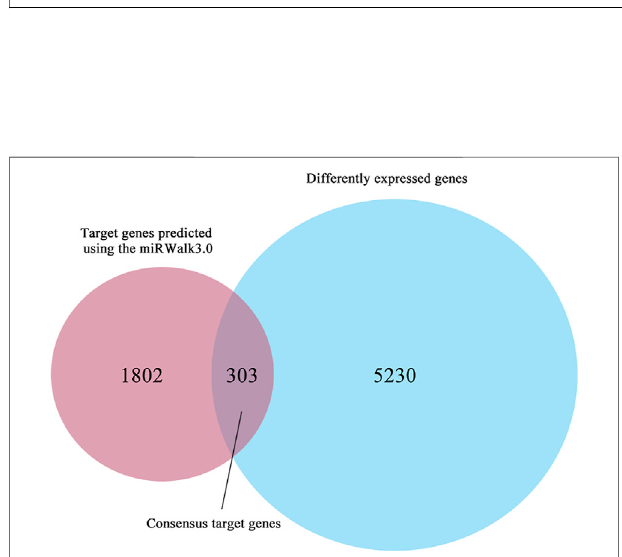
FIGURE 2 | The Venn diagram shows a total of 303 consensus